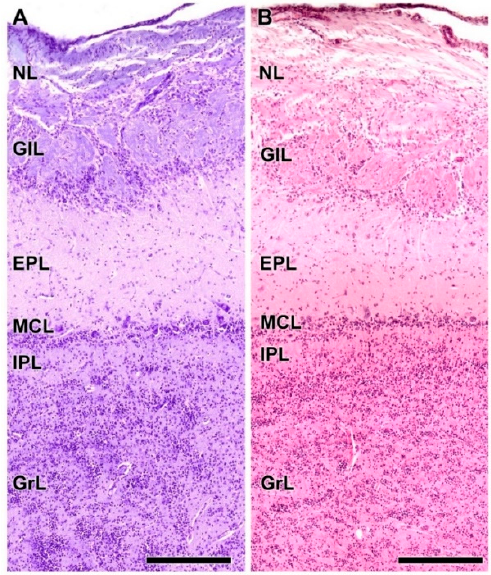
Figure 3. Histological study of the lamination of the olfactory bulb of the dog. Nissl ( A ) and hematoxylin–eosin staining ( B ) show the main layers of the MOB: olfactory nerve layer (NL), glomerular layer (GlL), external plexiform layer (EPL), mitral cell layer (MCL), internal plexiform layer (IPL) and granular layer (GrL). Scale bars: 250 µm.